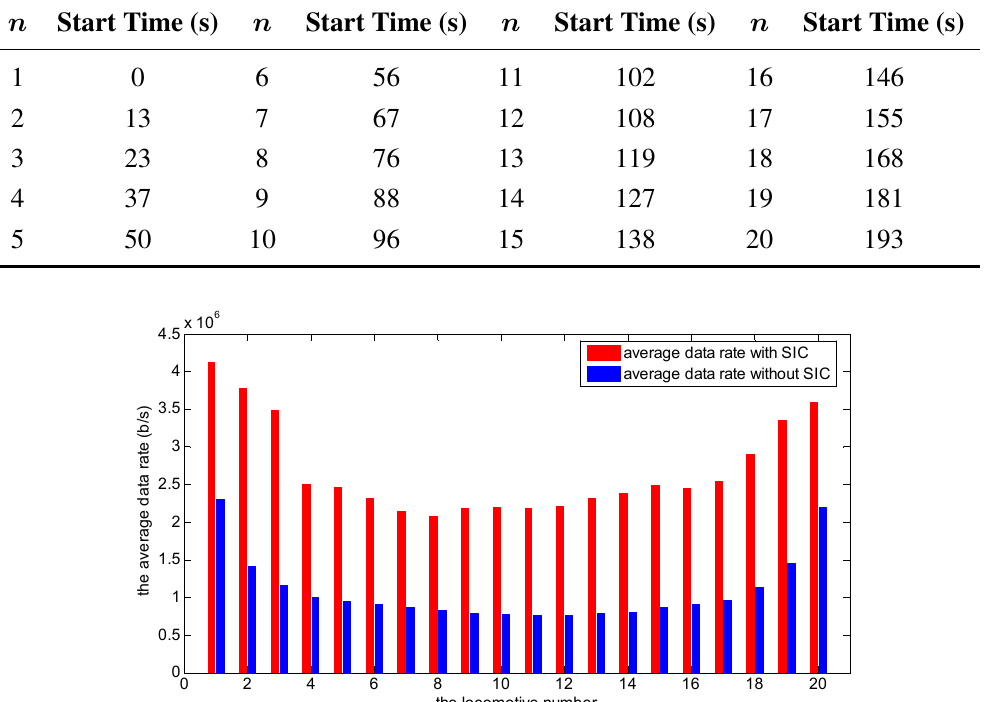
Figure 5. The comparison of average data rate with and without SIC for 20 locomotives. Table 2. Average data rates and scaling factors with and without successive interference cancellation (SIC) for the 20